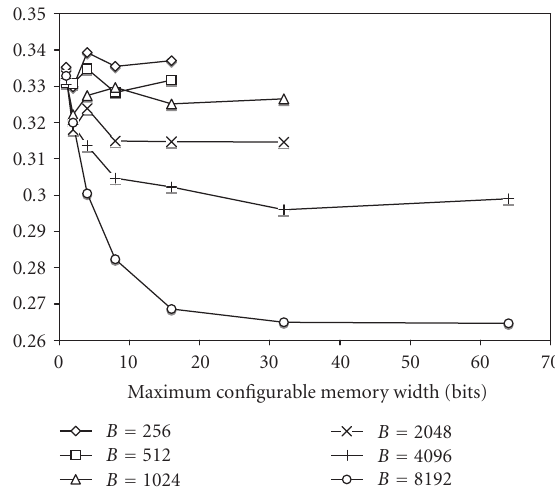
Figure 12: Impact on logic energy when increasing memory flexi- bility.